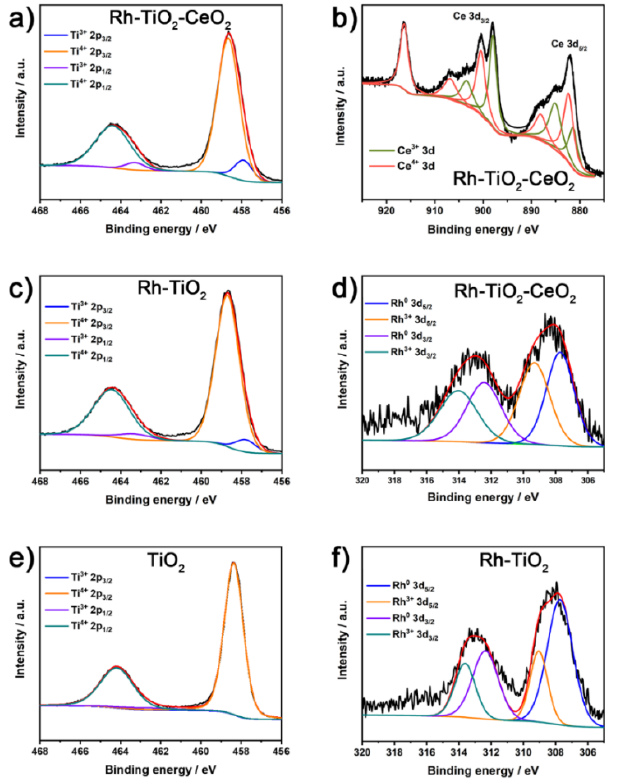
Figure 2. XPS spectra of ( a , c , e ) Ti 2p, ( b ) Ce 3d, and ( d , f ) Rh 3d for different photocatalysts.